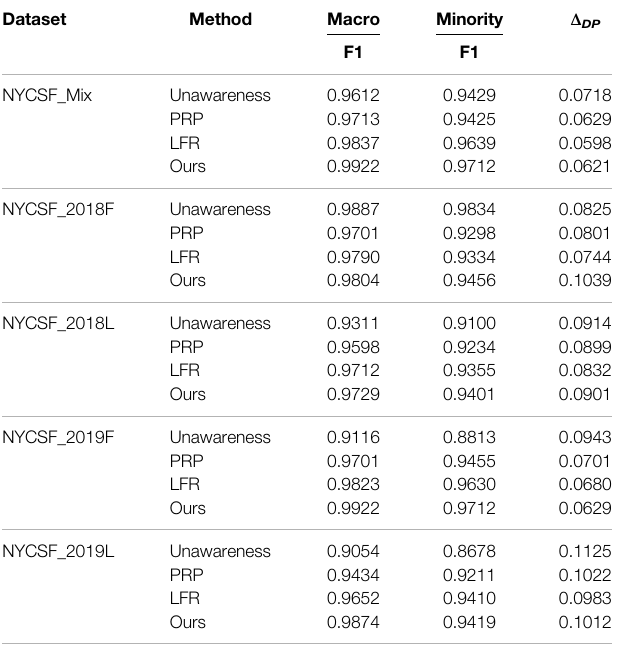
TABLE 3 | Ours VS fairness based methods.